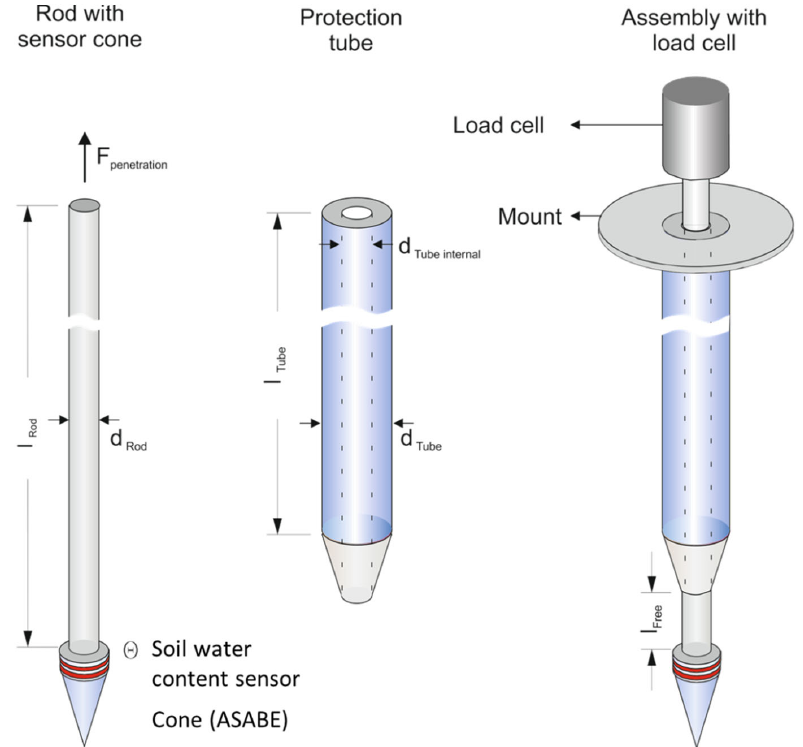
Figure 2. Design of the penetrometer lance for subsoil measurement, including rod with cone and sensor with two electrodes ( left ), the protection tube ( middle ), and the assembled penetrometer with load cell ( right ).